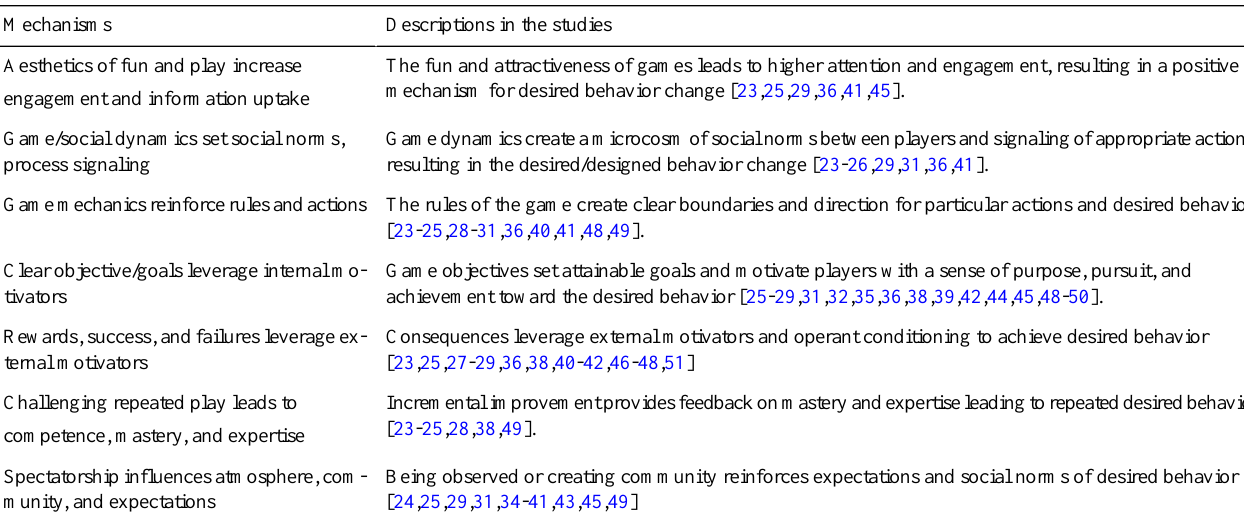
Table 2. Context and mechanisms leading to positive behavior change outcomes in a realistic game design theory. Descriptions in the studiesMechanisms The fun and attractiveness of games leads to higher attention and engagement, resulting in a positive [23,25,29,36,41,45].Aesthetics of fun and play increase mechanism for desired behavior change engagement and information uptake Game dynamics create a microcosm of social norms between players and signaling of appropriate actions, [23-26,29,31,36,41].Game/social dynamics set social norms, resulting in the desired/designed behavior change process signaling The rules of the game create clear boundaries and direction for particular actions and desired behavior [23-25,28-31,36,40,41,48,49].Game mechanics reinforce rules and actions Game objectives set attainable goals and motivate players with a sense of purpose, pursuit, and [25-29,31,32,35,36,38,39,42,44,45,48-50].Clear objective/goals leverage internal mo- achievement toward the desired behavior